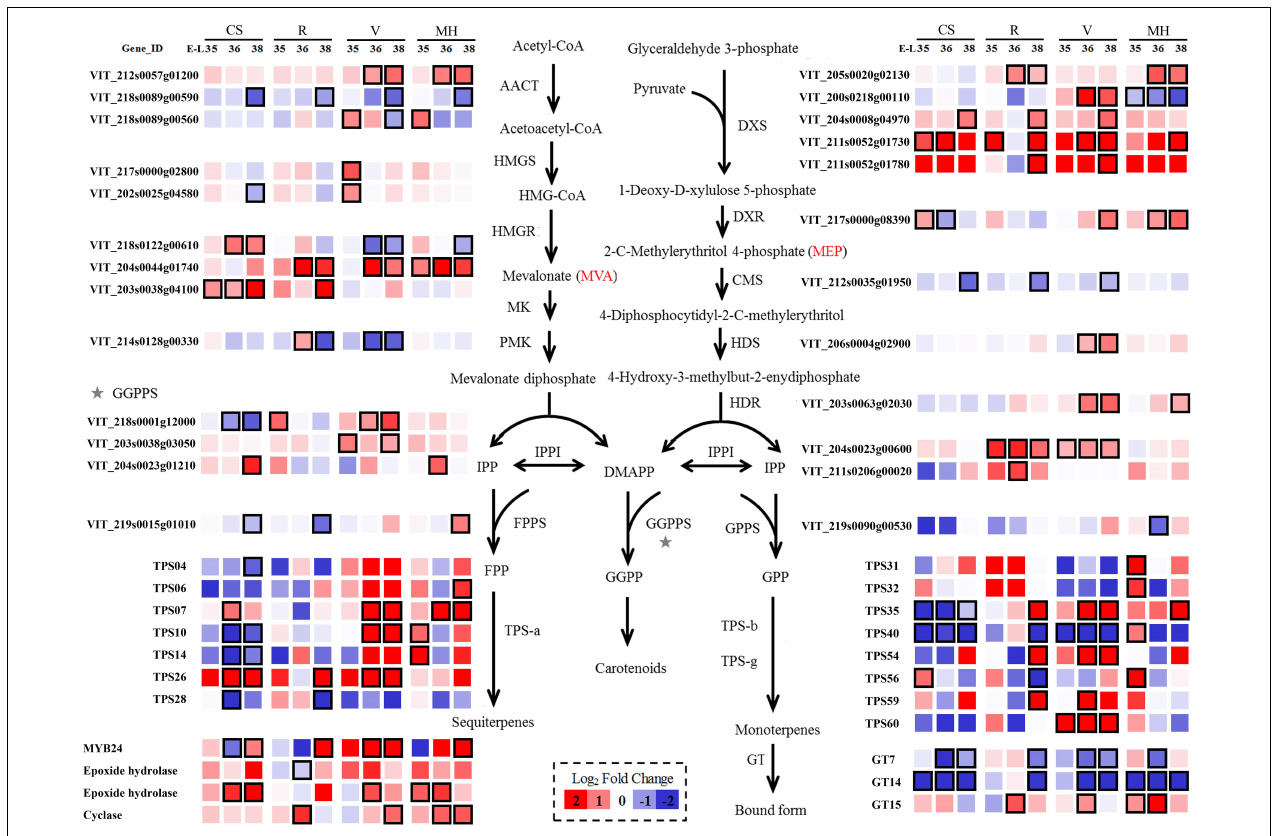
FIGURE 4 | Effect of the growing season on the expression profiles of MEP and MVA synthesis pathways during Cabernet Sauvignon, Riesling, Victoria, and Muscat Hamburg grapes development in 2014. Heatmaps show the log 2 fold change between the seasons (winter season/summer season). Red block indicates higher gene expression in the winter season berries. Blue block indicates lower gene expression in the winter season berries. Boxes with bold margins indicate differently expressed genes between the summer and winter season berries. MEP, 2-methyl- D -erythritol-4-phosphate phosphate; MVA, mevalonic